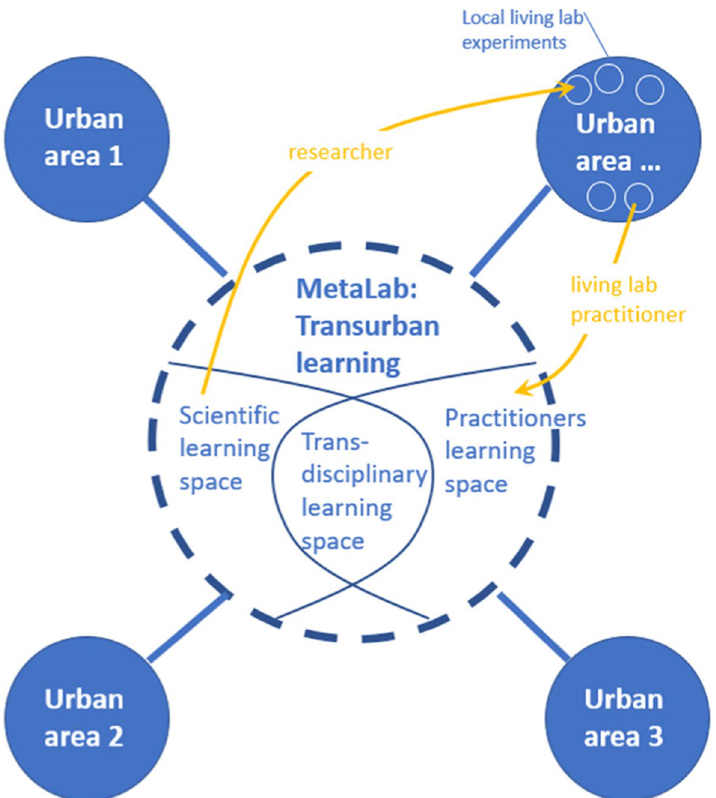
Fig. 1 The transurban learning coordination of the meta-lab